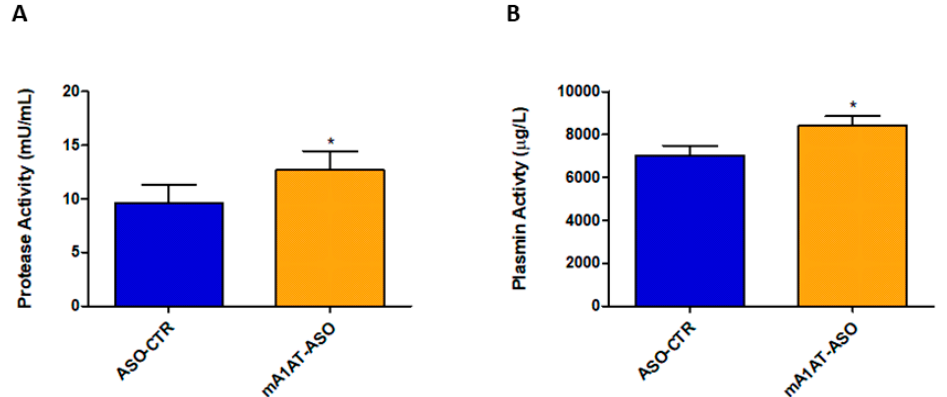
Figure 7. Serine protease activity and, particularly plasmin activity was found to be increased in mice plasmas upon SerpinA1 knockdown. Serine protease activity ( A ) and plasmin activity ( B ) were measured in plasma samples of HM30 mice according to the manufacturer’s instructions. Statistical analysis was performed using an unpaired t -test. * p < 0.05 comparing protease activity between ASO-CTR and mA1AT-ASO, t = 2.189, df = 14; * p < 0.05 comparing plasmin activity between ASO- CTR and mA1AT-ASO, t = 2.235, df = 16. Calculations were performed for an interval of confidence of 95%.